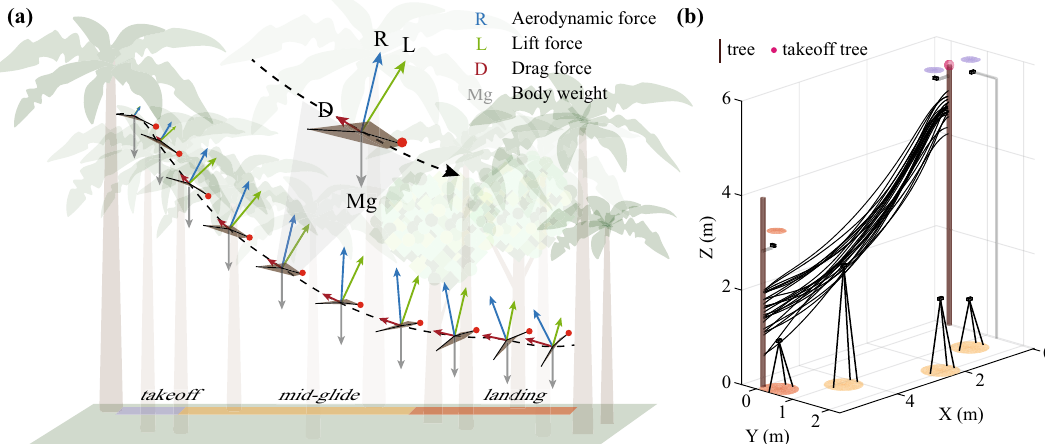
Figure 1. Illustration of the body posture and forces acting during a glide and the field motion capture arena. ( a ) Free body diagram showing the forces experienced by a gliding animal at various stages of the complete glide as well as the change in body orientation. The glide is further divided into the three distinct glide phases of takeoff, mid-glide, and landing. ( b ) A scaled illustration of the motion capture arena showing all 24 smoothed glides (see SI-3.2) and the seven camera positions used to collect 3D kinematic data. The seven cameras are divided into three groups (color coded) based on the part of the glide they record. The takeoff cameras are marked by purple discs, glide cameras with orange, and landing cameras with red.